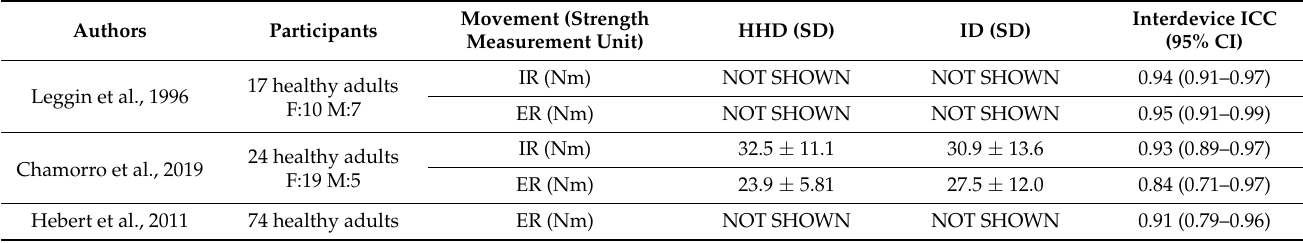
Table 4. Outcome descriptions of studies analyzing concurrent validity between HHD and ID.